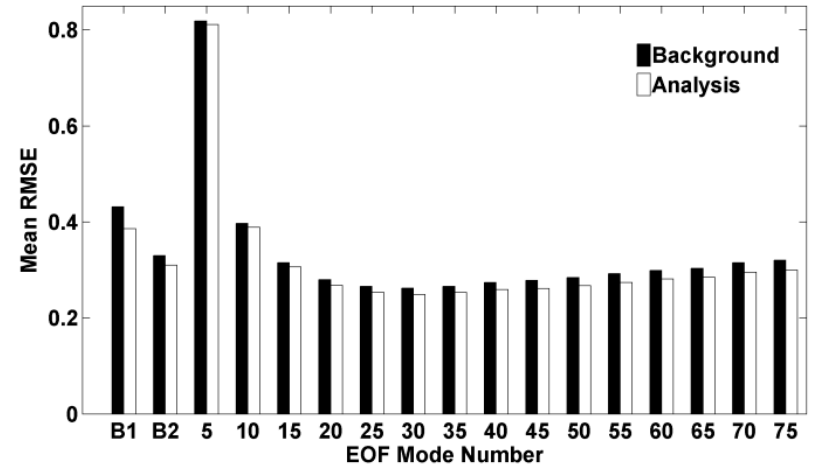
Figure 3. The mean RMSEs of the DRP-4DVar with m set as a serious different value from 5 to 75. Other assimilation parameters of the DRP-4DVar experiments are the same as those of the DRP-4DVar experiment in Exp-1. The mean RMSEs of the ETKF and the 4DEnVar methods in Exp-1 are used as benchmarks, which are noted as B1 and B2, respectively. The black bars and white bars denote the mean background RMSE and the mean analysis RMSE during the last 500 time steps, respectively.